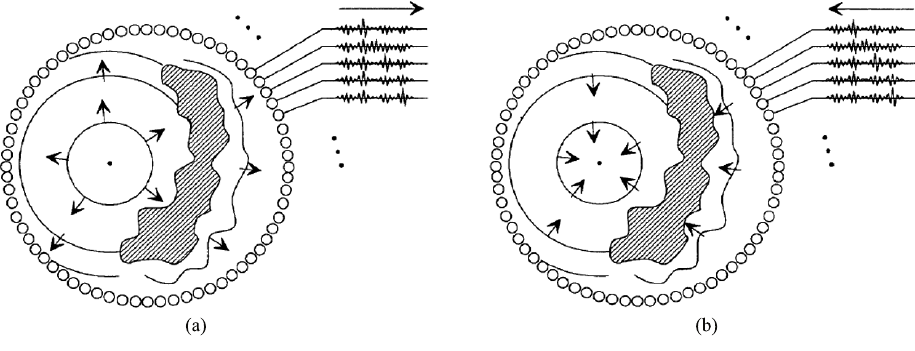
Fig. 1. Two operation steps of time-reversal procedure